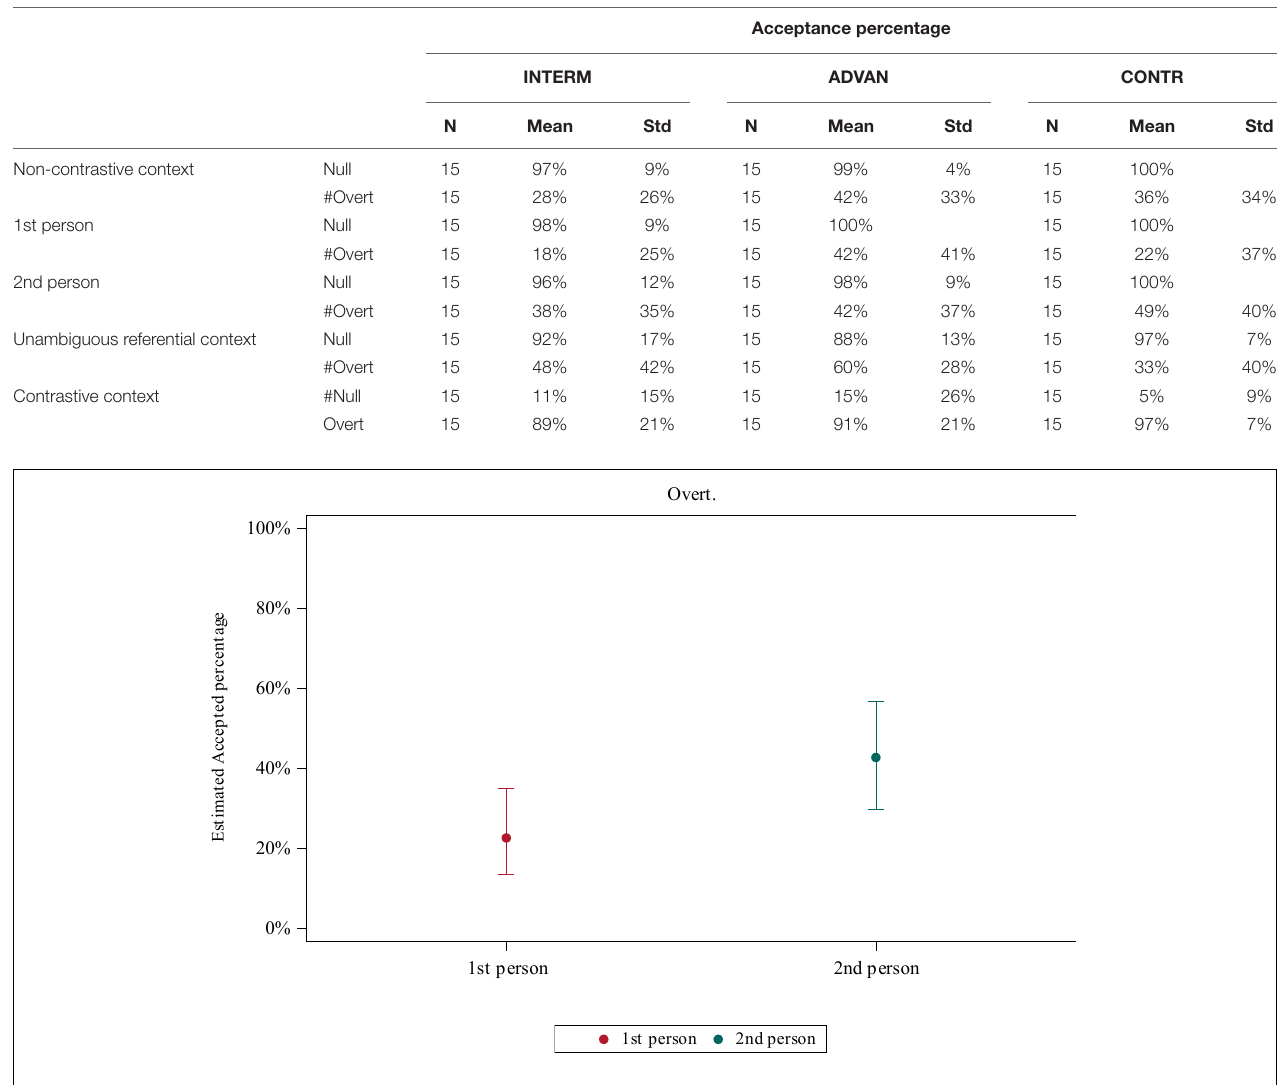
FIGURE 1 | Estimated acceptance percentage according to Person in the overt subject